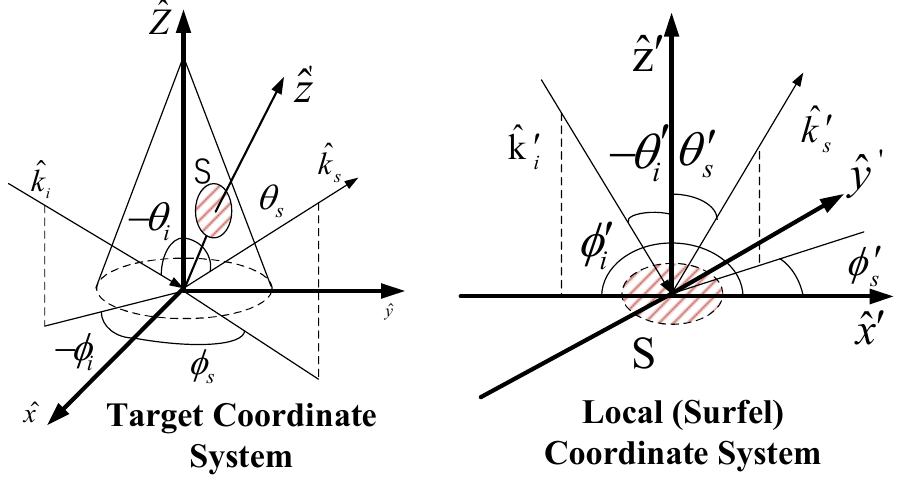
Figure 1. Target coordinate system and surface element coordinate system of a rough cone model.